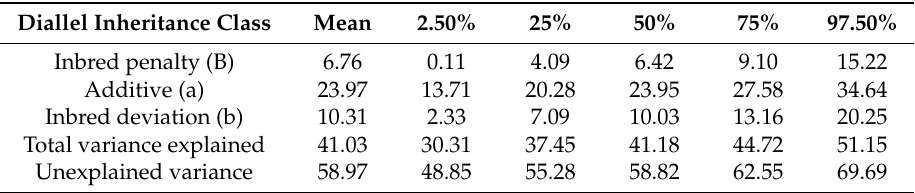
Figure 5. Diallel variance projections of the genetic architecture for total yield. Table 3. Diallel variance projection approach (VarP) for the tomato total yield